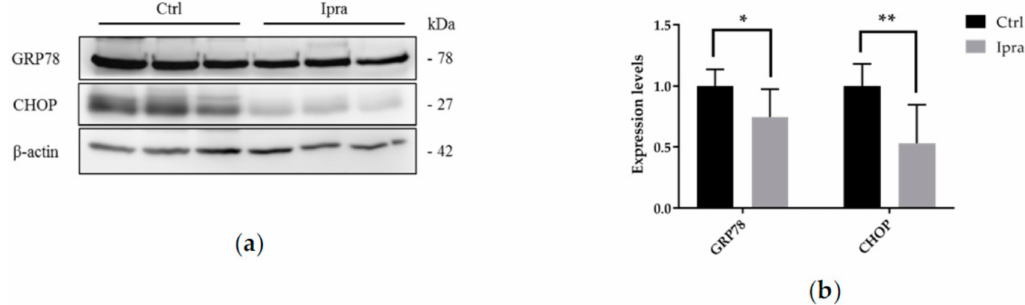
Figure 5. Endoplasmic reticulum stress-associated protein expression. ( a ) Western blot analysis for endoplasmic reticulum-associated proteins on kidney tissues from FLS- ob / ob mouse. Beta-actin is used as a loading control. ( b ) Quantification of western blot signal intensities, expressed relative to control group. Bars indicate average ± SEM. * p < 0.05; ** p < 0.01 (unpaired t -test). Ctrl, control group; Ipra, ipragliflozin